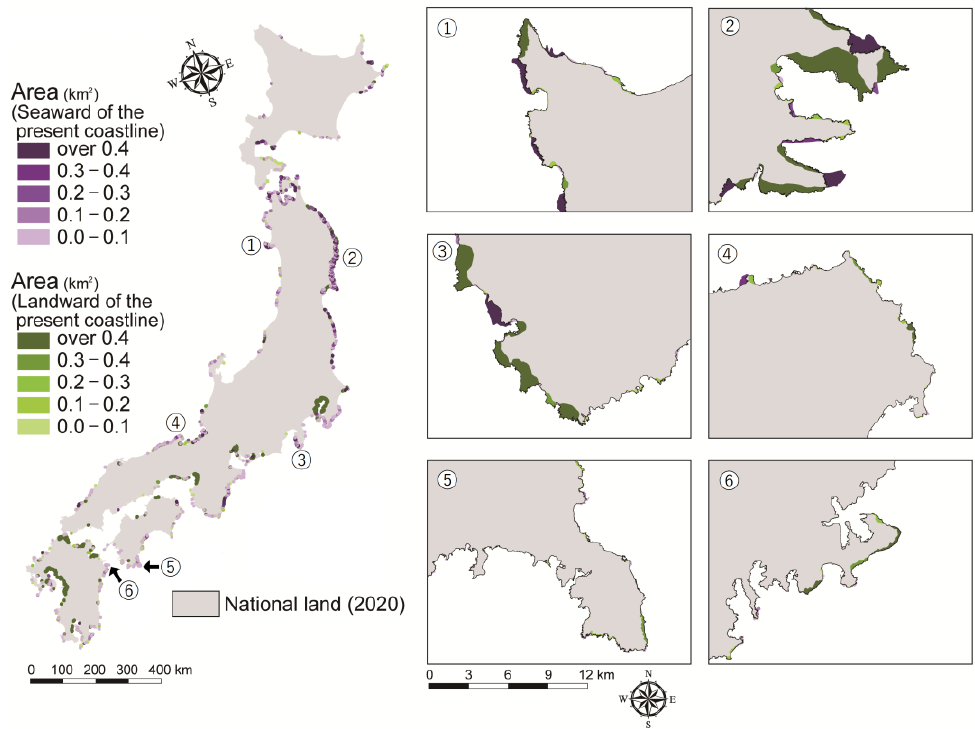
Figure 8. Distribution of gaps in the non-surveyed (estimated) coastlines. The right maps show the enlarged views of each area. Table 1. Number of gaps and their areas in the non-surveyed (estimated) coastlines in Japan.